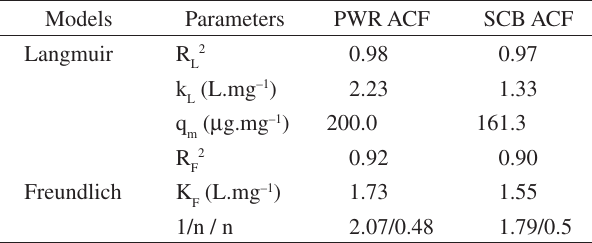
Table 4. Parameters of the Langmuir’s and Freundlich’s adsorption models.